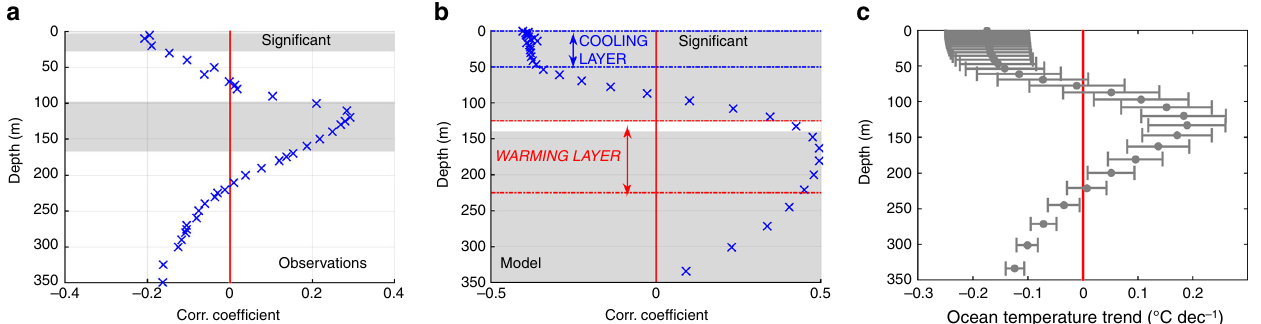
Fig. 2 Correlation coef fi cients between ice concentration and depth-dependent ocean temperature trends in the Ross Sea. Observation-based correlations a are computed from the OSISAF 21 sea-ice concentration satellite product and ocean temperature pro fi les from the BLUELink Ocean Archive 27 . The same diagnostic is applied to a simulation performed with the ocean – sea-ice model NEMO-LIM3.6 ( b , see Methods section). c depicts the mean depth- dependent ocean temperature trends (model-based) over Ross Sea areas, where ice concentration trends are positive and considered signi fi cant, i.e., larger than 3% dec − 1 , the 95% con fi dence interval for ice concentration trends in the model, and observations. The regions associated with b and c are thus slightly different, with b including areas with deeper MLD. At each depth, the horizontal bar represents the standard deviation around the spatially averaged trends. Trends are computed over 1979 – 2013 and 1979 – 2014 for the model and observations, respectively. Gray areas show the depths at which the correlations are signi fi cant at the 95% con fi dence level. Below 220 m, a and c show negative correlations and trends that are probably due to processes